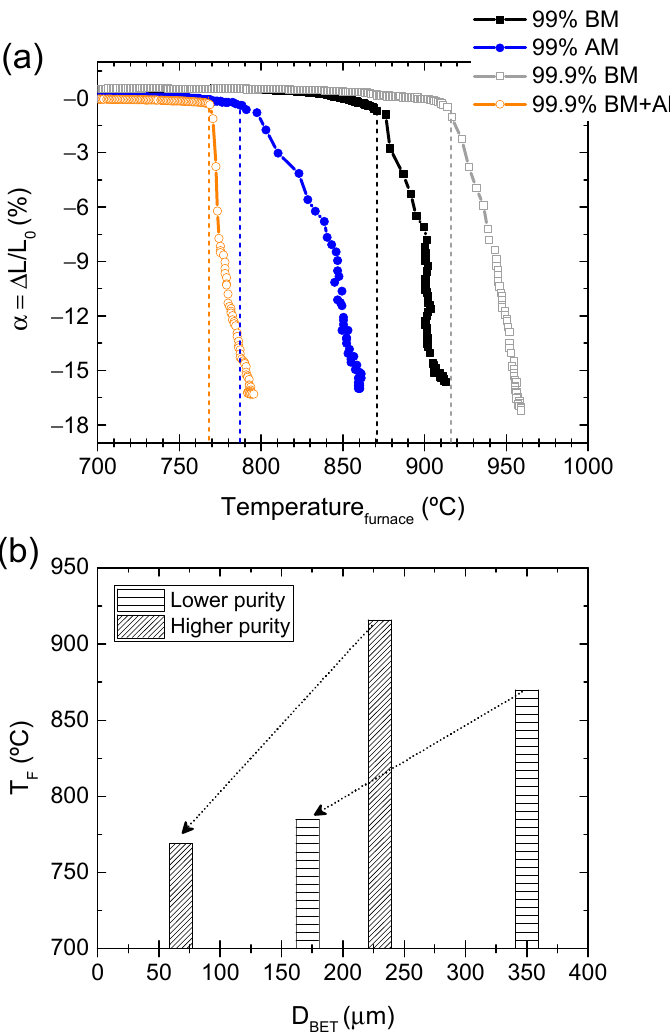
Figure 3. ( a ) relative displacement ( α ) as a function of furnace temperature during FLASH sintering of the produced powders (10 ◦ C/min heating, 300 V/cm, 20 mA/mm 2 current limit, 60 s holding time), and ( b ) schematic representation of T F versus the particle size (D BET ), revealing the tendency of T F to decrease with particle size diminution and impurity content increase.